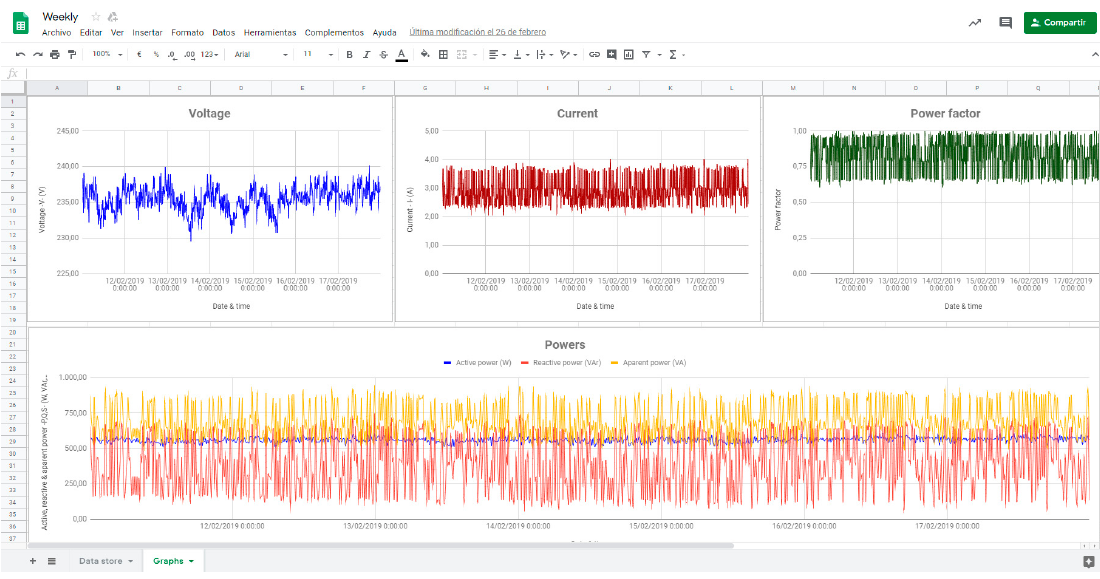
Figure 23. Graphs sheet.